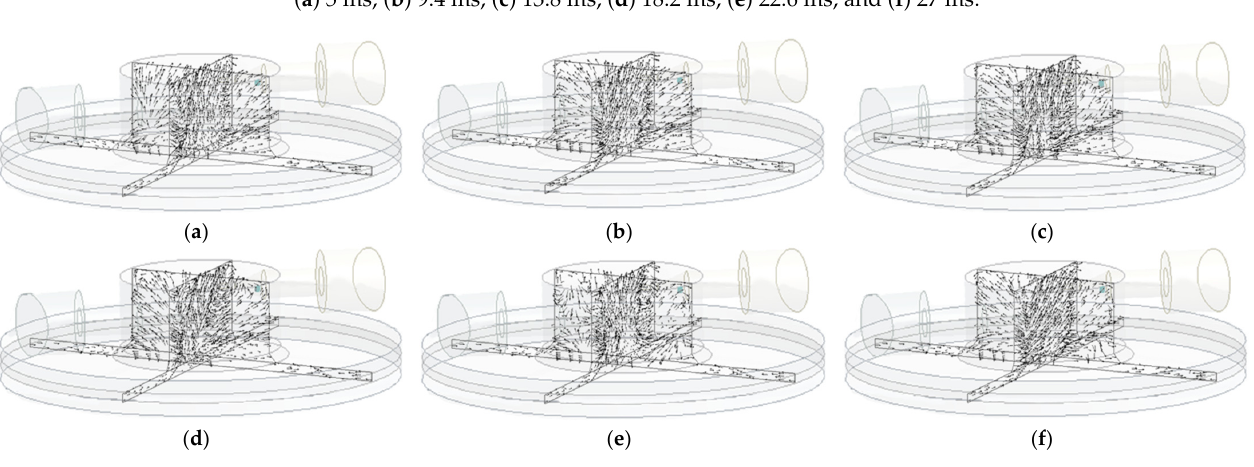
Figure 21. When inlet pressure = 15 MPa, gap = 1.5 mm, the variation of the velocity vector plot of the original suction cup with time in sequential planes views (from top view and bottom view) at: